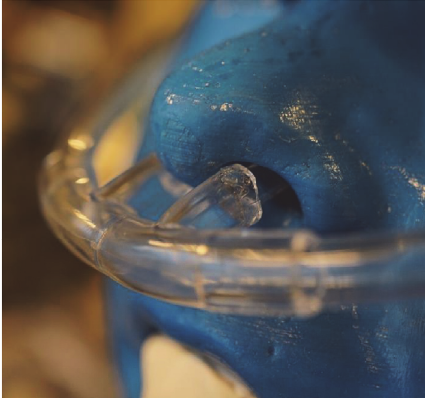
Figure 2: Model of child’s airway with modified reservoir cannula.